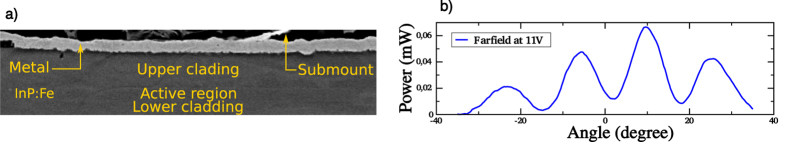
SEM picture of the laser with a cracked facet (a) and horizontal far-field at 11 V (b).